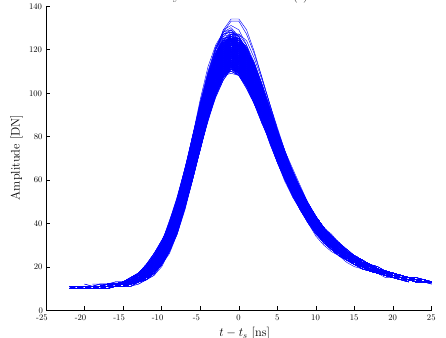
Figure 3: Overlay of 2 000 randomly chosen system waveforms